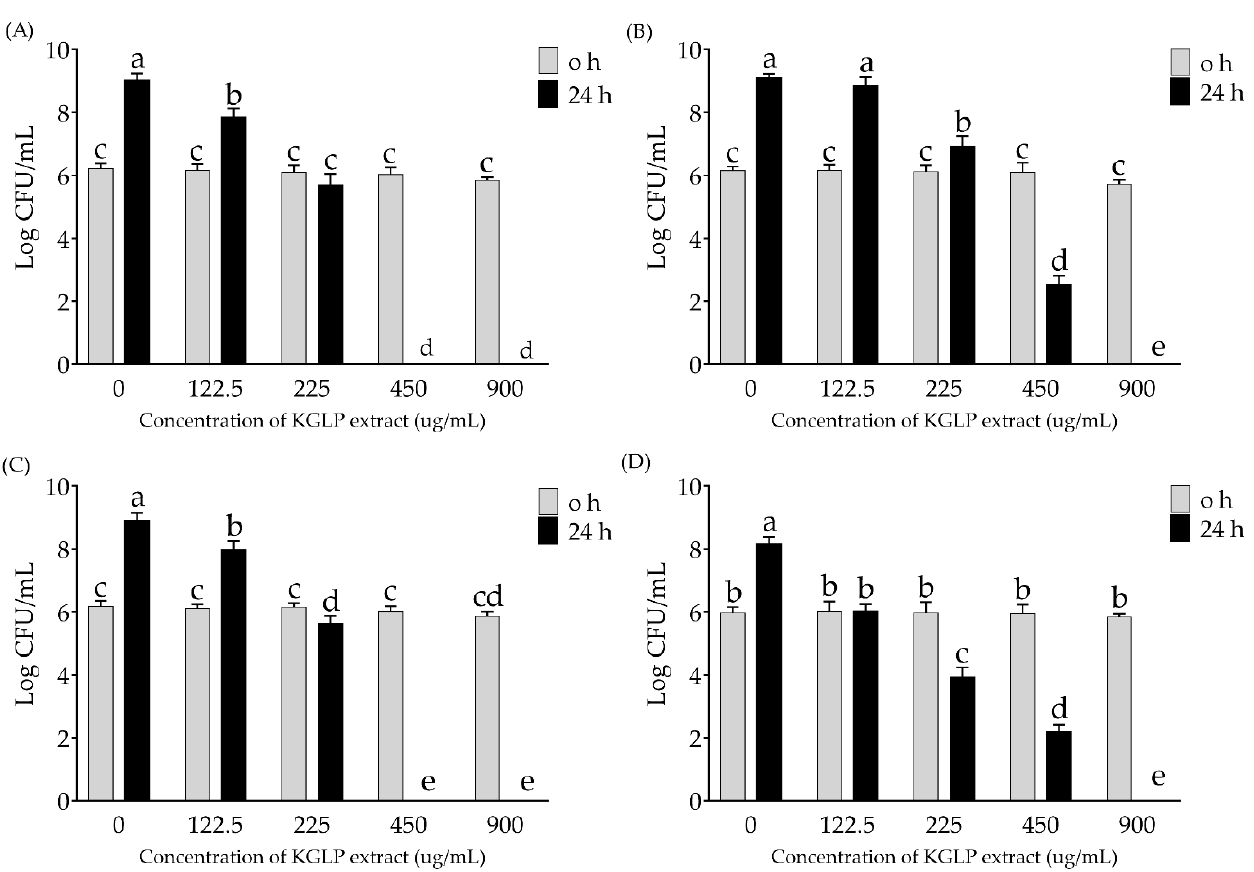
Figure 2. Antimicrobial activity of KGLP extracts on foodborne pathogens. ( A ) S. aureus , ( B ) E. coli , ( C ) S. Enteritidis , and ( D ) V. parahaemolyticus . The values are expressed as mean ± SD ( n = 3). Different superscript letters indicate significant difference at p < 0.05.